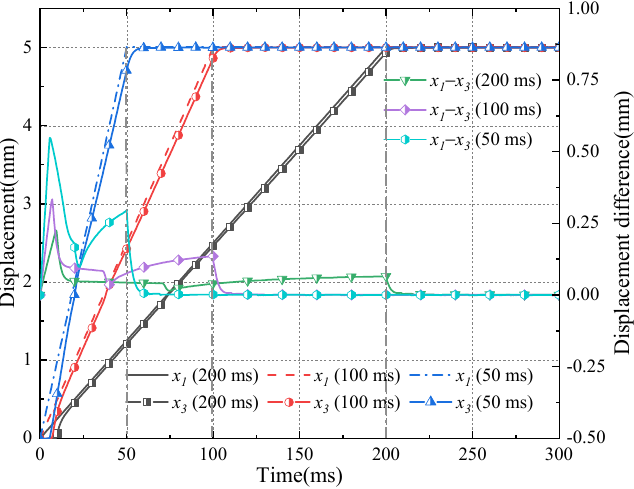
Figure 16. The ramp response of the proportional valve.